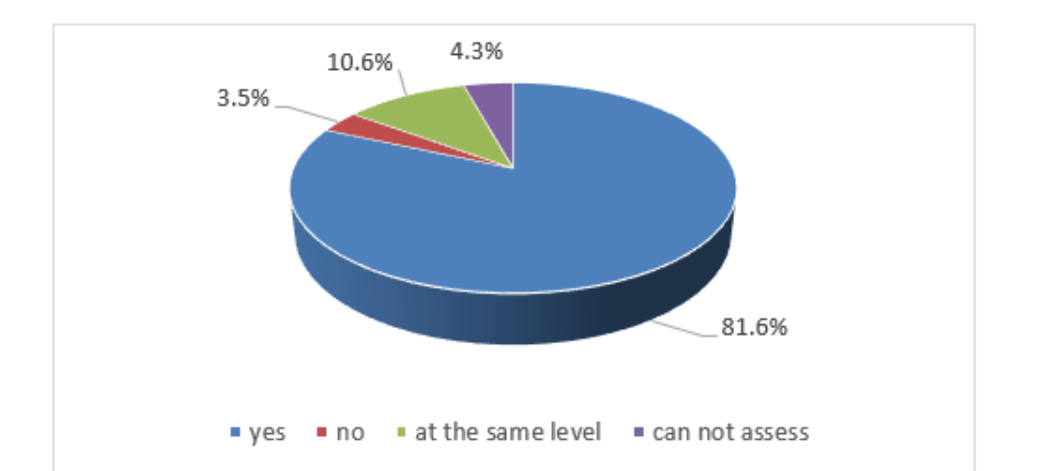
Figure 1. The response of students to the question: Was the education in the WT 20/21 managed better than the education in the ST 19/20?